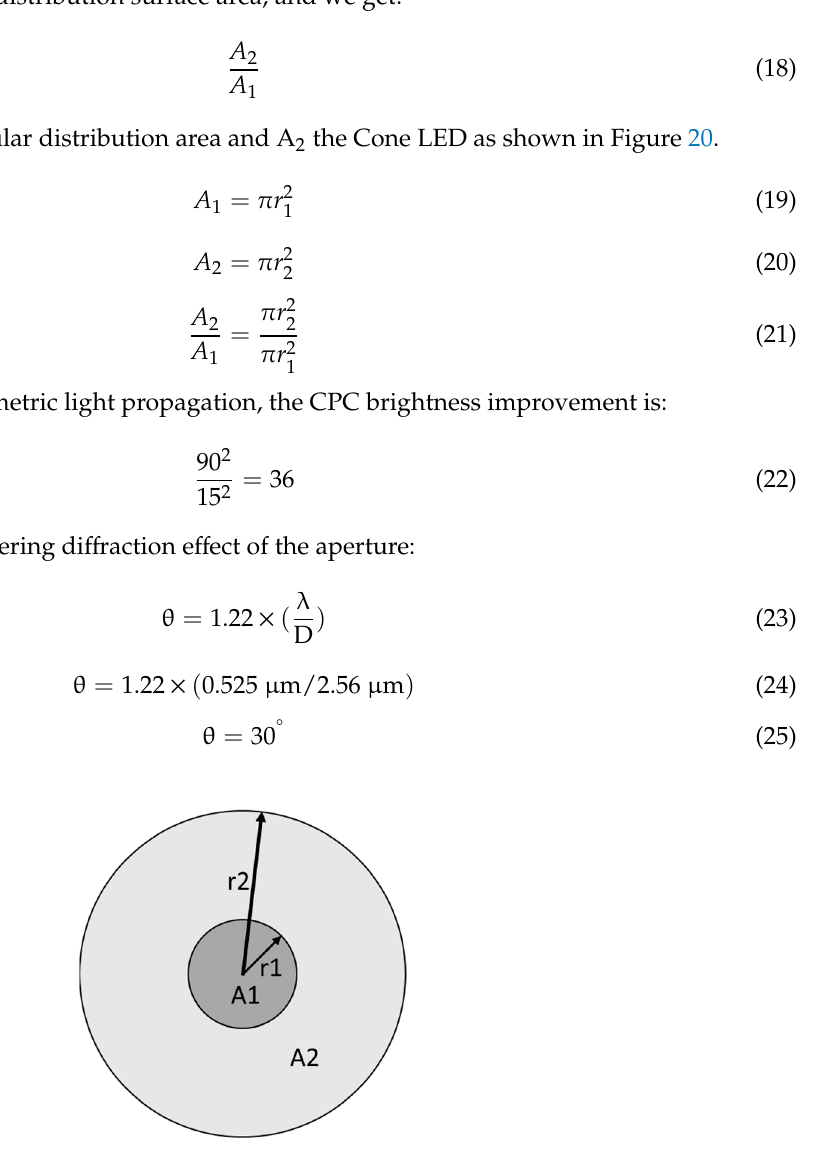
2 and the CPC output beam radius r 1